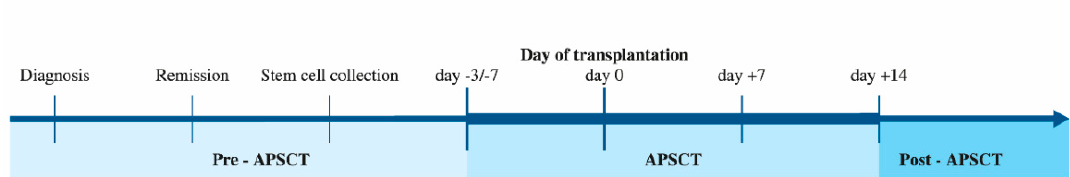
Figure 1. Study design. Timeline of autologous peripheral stem cell transplantation (APSCT). Saliva and serum sampling were performed at the four defined time ‐ points of APSCT (day − 3/ − 7, day 0, day +7, day +14). Timescale pre ‐ and post APSCT were different among the individual cases (i.e., the thin line is not proportional to the elapsed time). Day − 3/ − 7 is the time of admission and start of the conditional therapy; day 0 is the day of the transplantation (administering the harvested CD34+ stem cells in a stem cell infusion); day +7 is usually the deepest point of cytopenia with most severe oral mucositis; by day +14, neutrophil and thrombocyte engraftment has developed if insertion and proliferation of stem cells were successful.